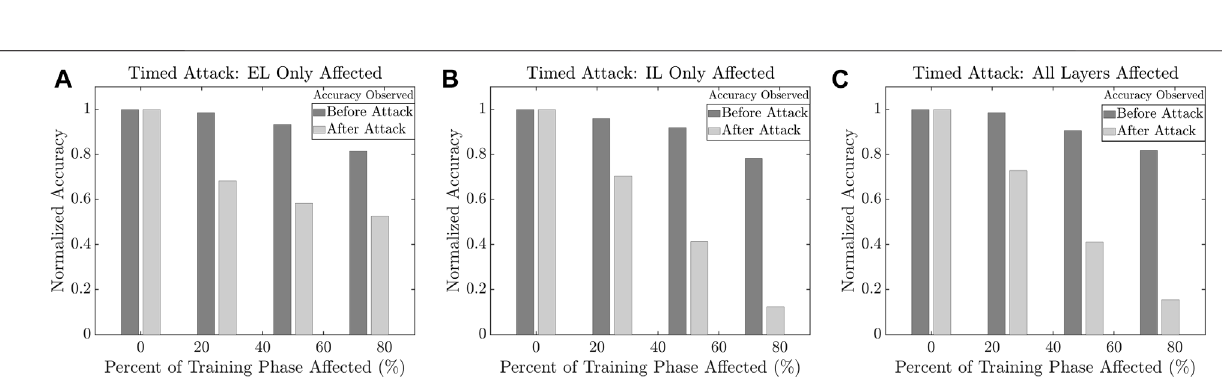
Frontiers in Nanotechnology |